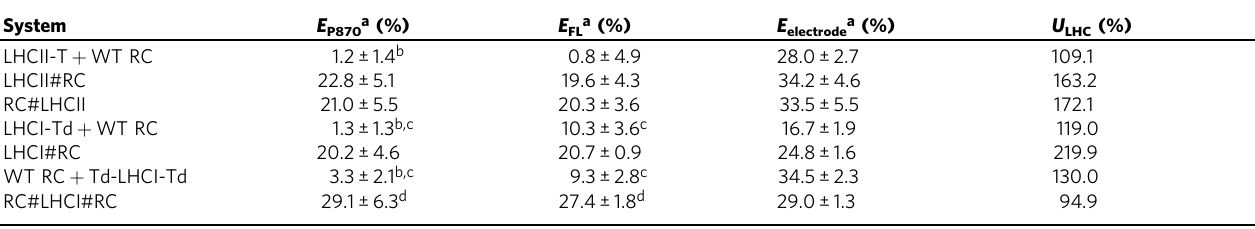
Table 1 Apparent energy transfer ef fi ciencies and associated parameters.